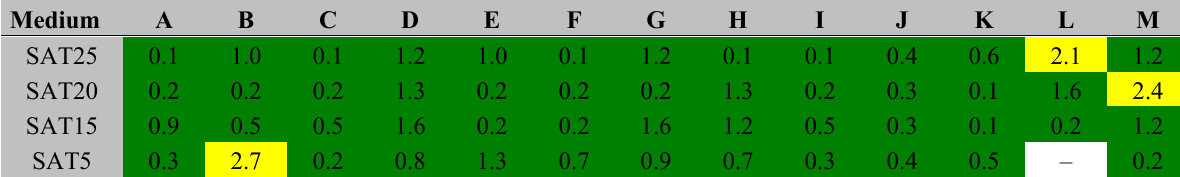
Table 10. The | z | values of the participants for temperature measurement a